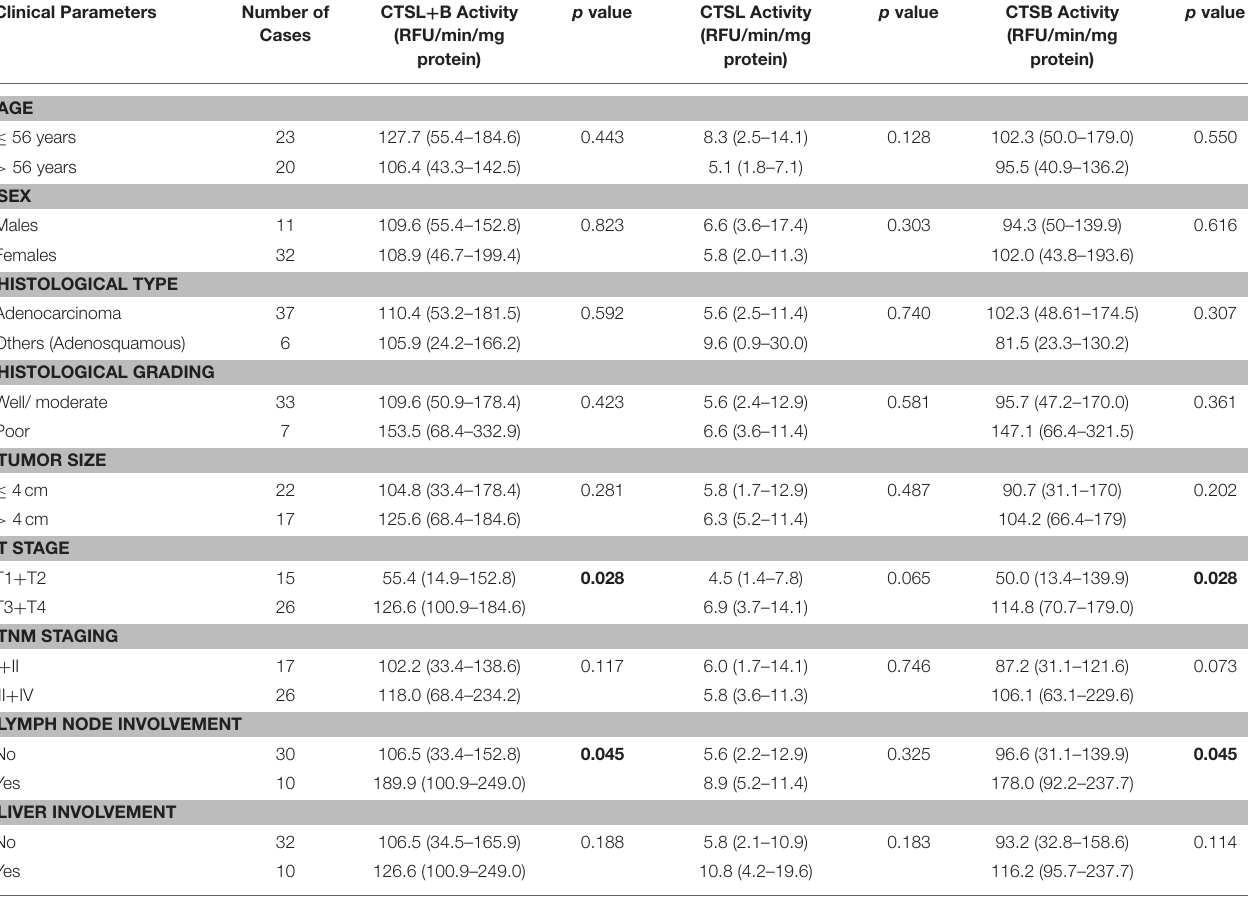
TABLE 1 | Association of clinicopathological variables with CTSL + B, CTSL, and CTSB enzymatic activity in GBC tissues. Clinical Parameters